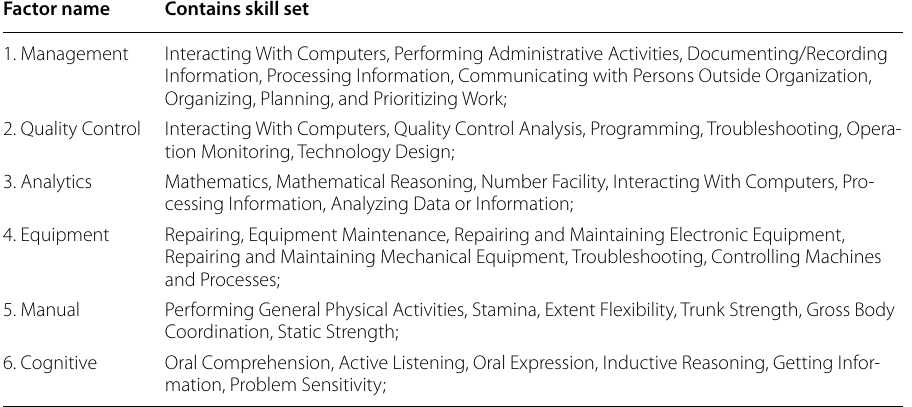
Table 6 NMF O*NET